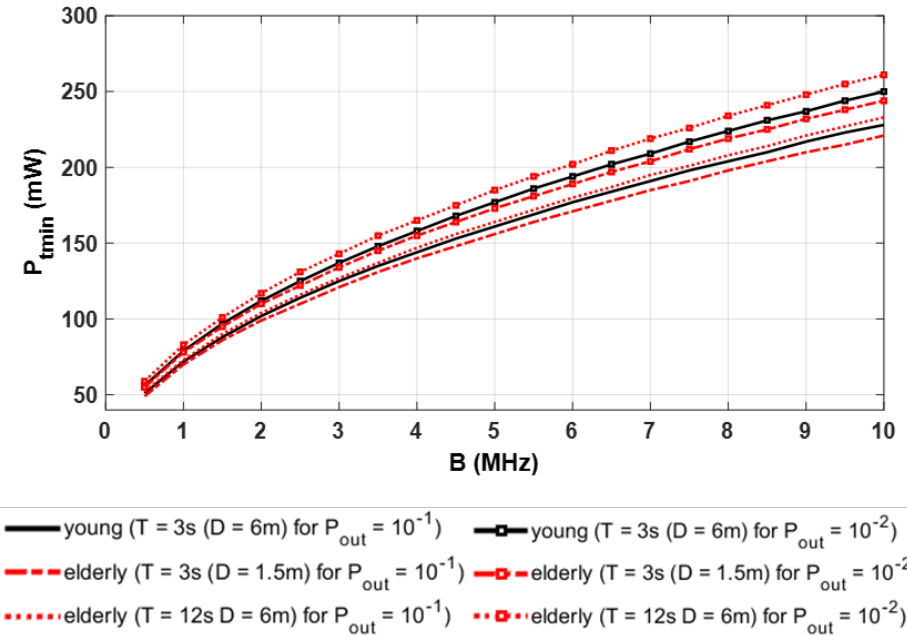
Figure 15. Evolution of emitted power as a function of bandwidth for γ 0 = 15.6 dB with ϕ 1/2 = 45 ◦ ( m = 2 )